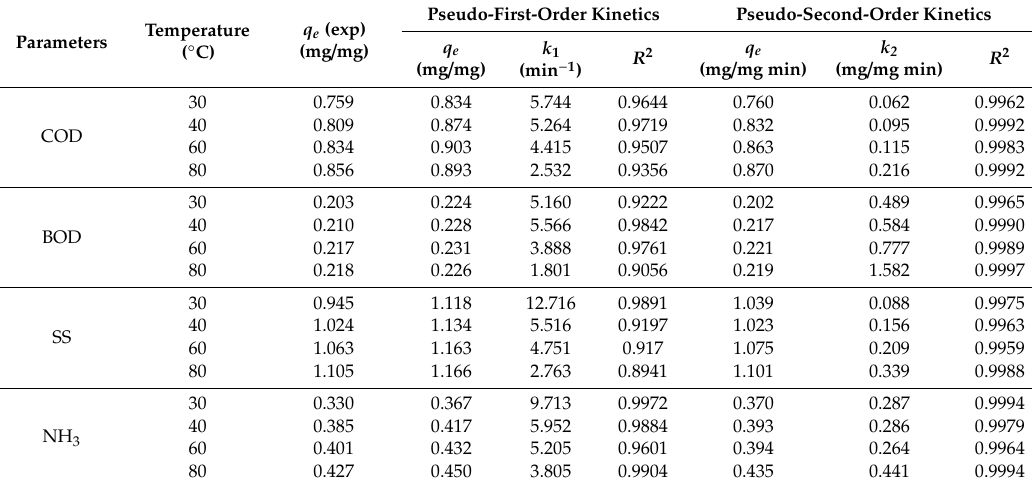
Figure 11. Adsorption kinetics studies for the removal of SS from SRPE using FeSO 4 ·7H 2 O as a coagulant. ( a ) Pseudo-first-order kinetics model and ( b ) pseudo-second-order kinetics model. Table 4. Kinetics parameters for the removal COD, BOD, and TSS from SRPE using FeSO 4 · 7H 2 O as a